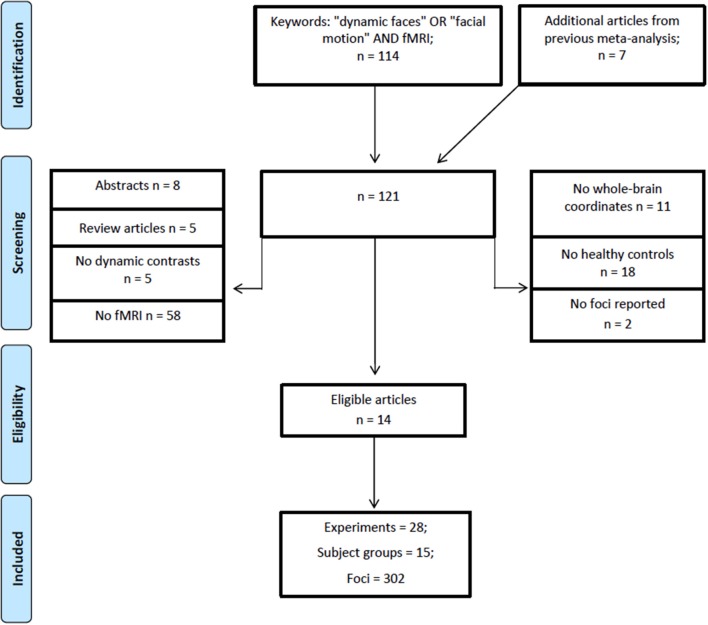
PRISMA flowchart for eligibility of articles (Template by Moher et al., 2009).